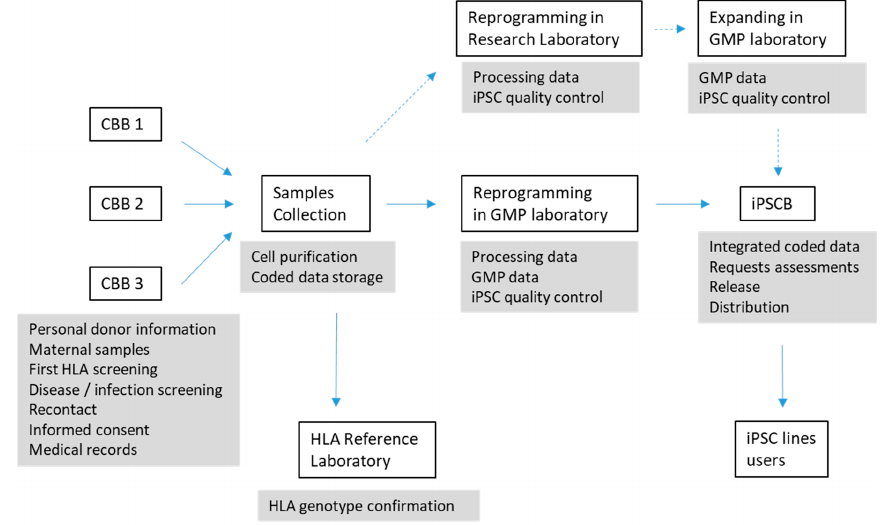
Figure 1. Different steps of the process of repurposing a cord blood bank (CBB) to iPSC bank (IPSCB) and identification of areas for the definition of SOP.